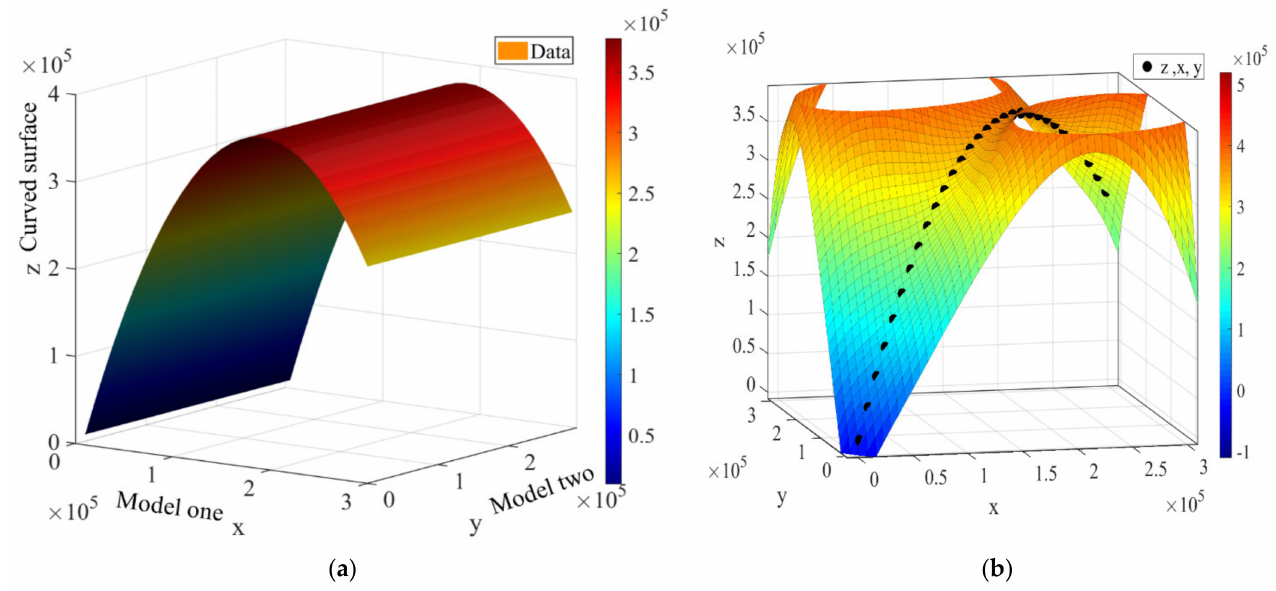
Figure 11. Model analyses 1 and 2: ( a ) Environmental impact and economic cost curved surface analysis; ( b ) Interpolation approximation analysis.